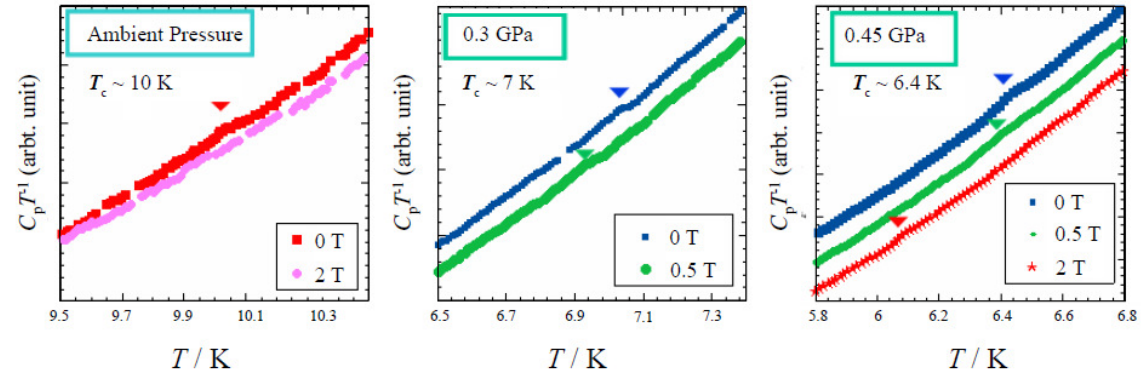
Figure 14. Temperature dependence of heat capacity around the superconductive transition of κ -[(BEDT-TTF)